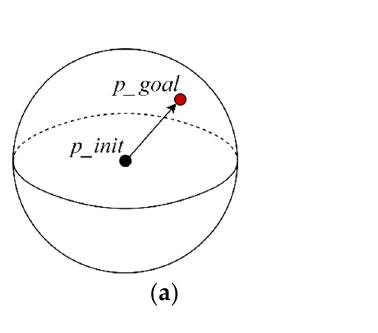
Figure 5. Sub-target point selection strategy: ( a ) target point within the window; ( b ) the intersection not in the obstacle; ( c ) the intersection in the obstacle.